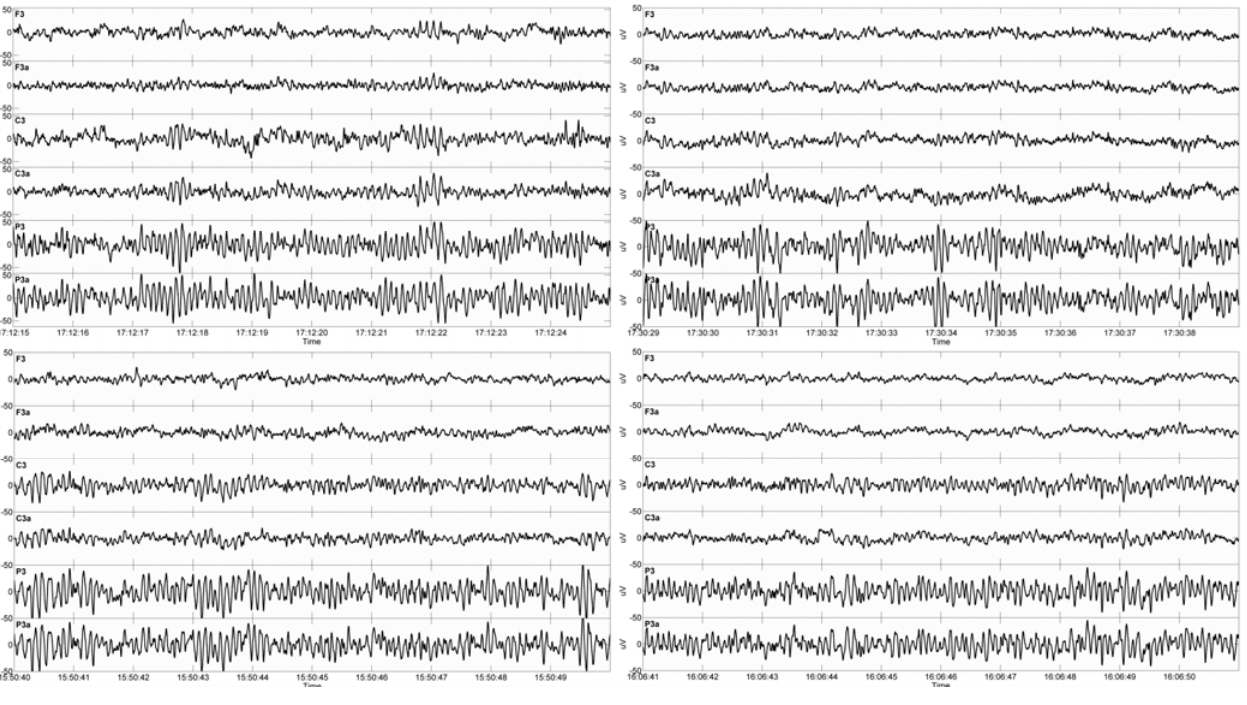
Figure 6. Example of EEG signals in the Matlab environment. Ten seconds of EEG with amplitude scale ±50 µV. Pair wise display of signals from the three pairs of standard (F3, C3, P3) and textile (F3a, C3a, P3a) electrodes. Top left: Type I with gel, top right: Type I with NaCl, bottom left: Type II with gel, bottom right: Type II with